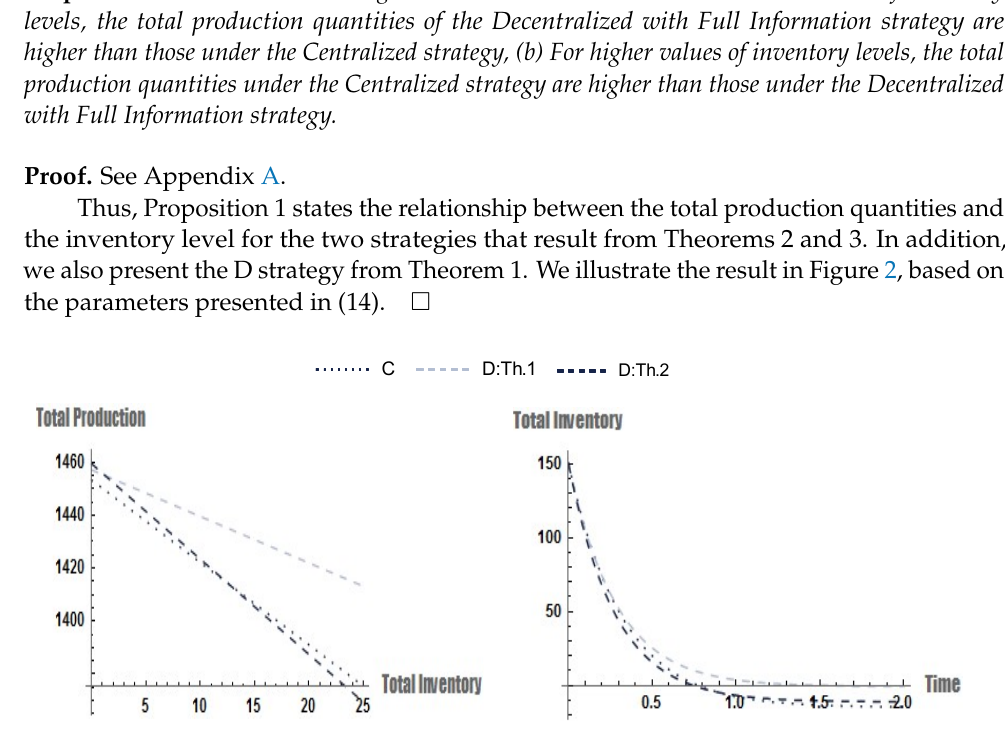
Figure 3. Total profits and emission costs as a function of time.